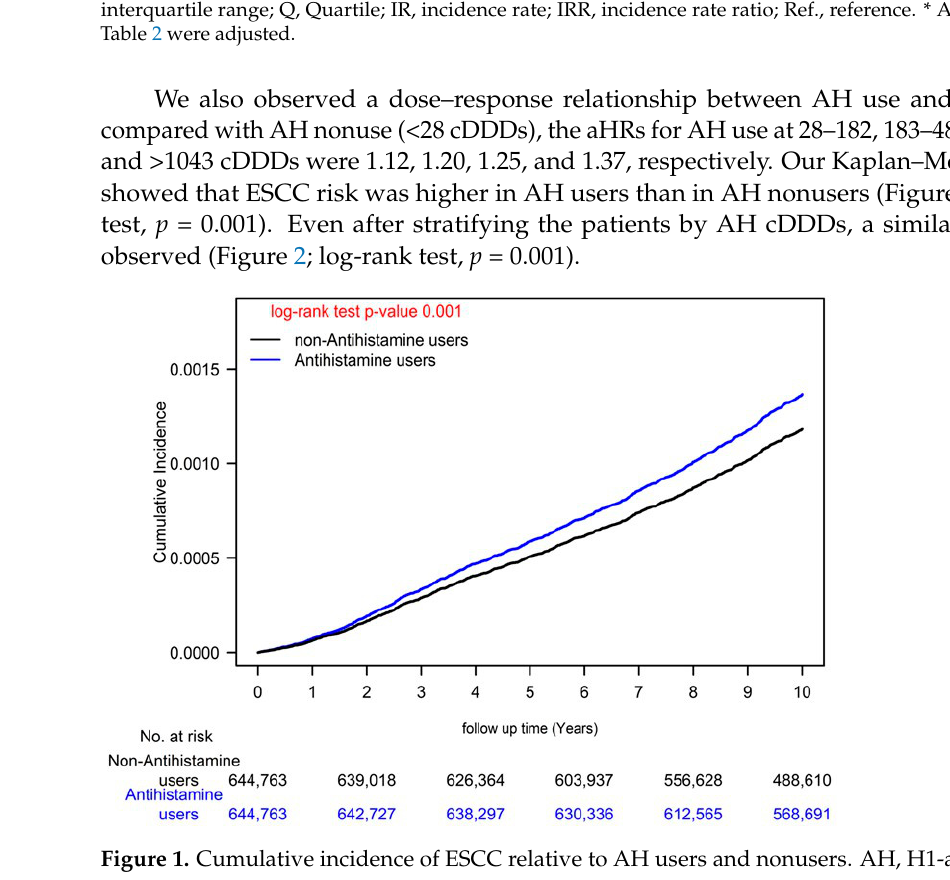
Figure 2. Kaplan–Meier cumulative incidence for ESCC at different cDDDs of AH use. AH, H1 ‐ antihistamine; ESCC, esophageal squamous cell carcinoma; cDDD, cumulative defined daily dose; Q, Quartile.